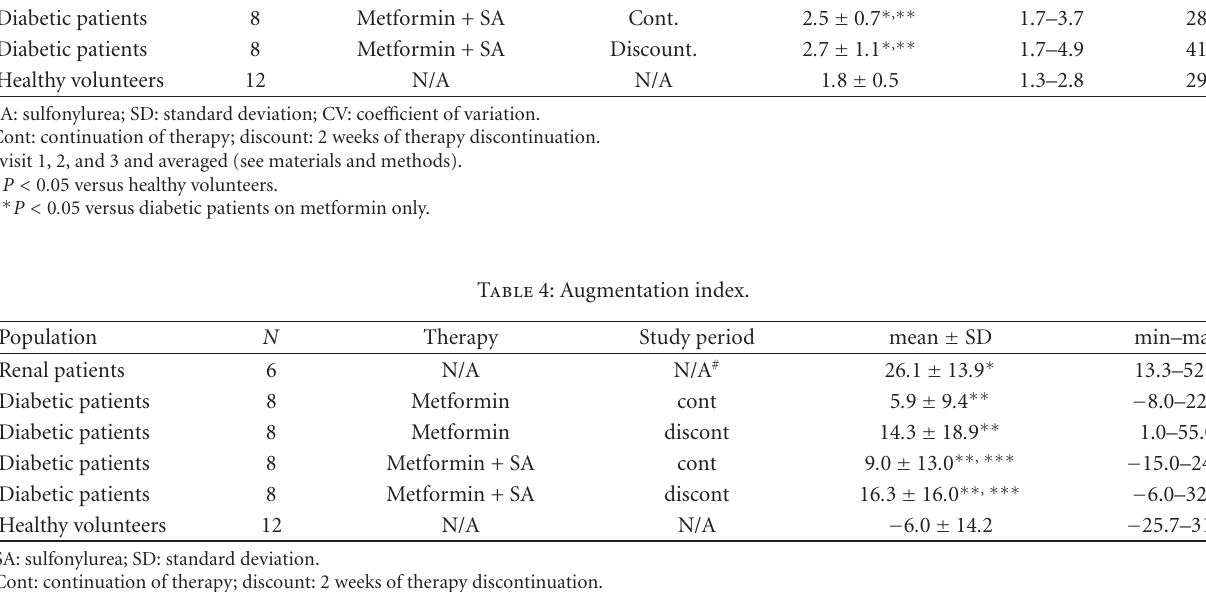
(Table 4: 26 . 1 ± 13 . 9 in patients versus − 6 . 0 ± 14 . 2 in